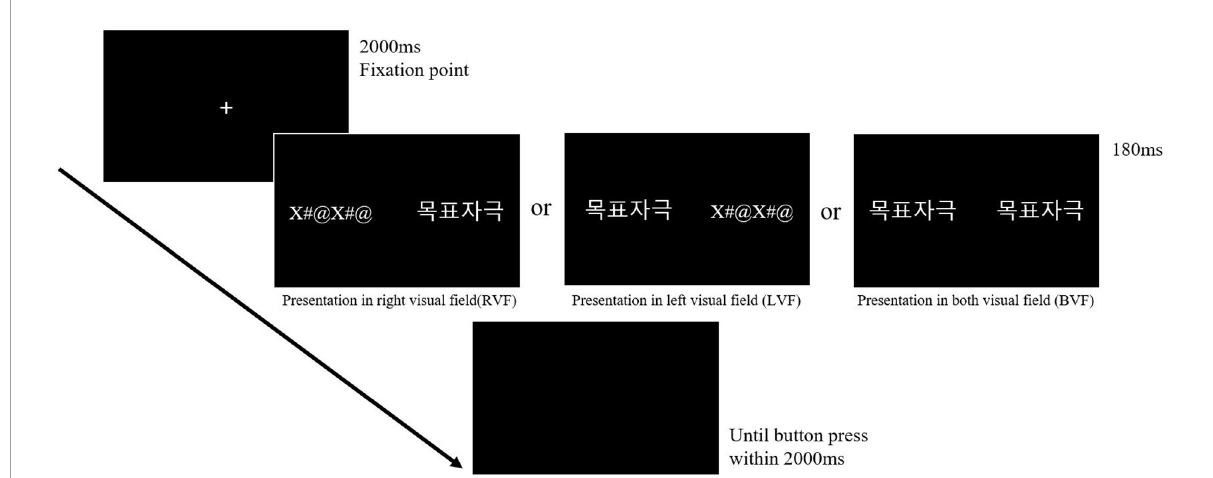
FIGURE1 Experimental paradigm of the lateralized lexical decision task. The fixation point was presented for 2,000 ms to make subjects fixate in the middle of the screen. Then, the stimuli were presented in the RVF, LVF, or BVF with the presentation of the string of symbols (“X#@X#@”) in the opposite visual field in the case of the RVF and the LVF. Subjects were required to make a lexical decision after the disappearance of stimuli within 2,000 ms to proceed next trial. This figure presents the location of the target at each visual field with “ (target)” in Korean.